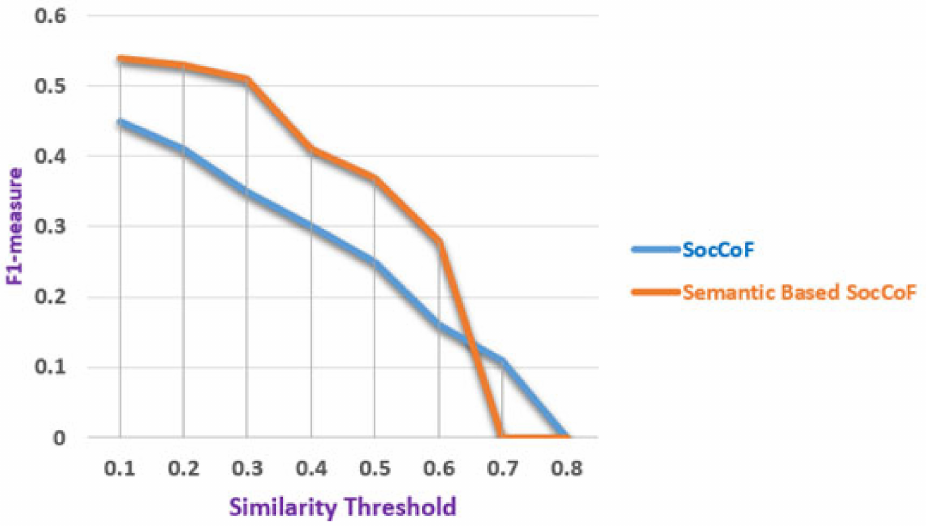
Figure 13. F1 measure of semantic-based SocCoF and SocCoF algorithms.